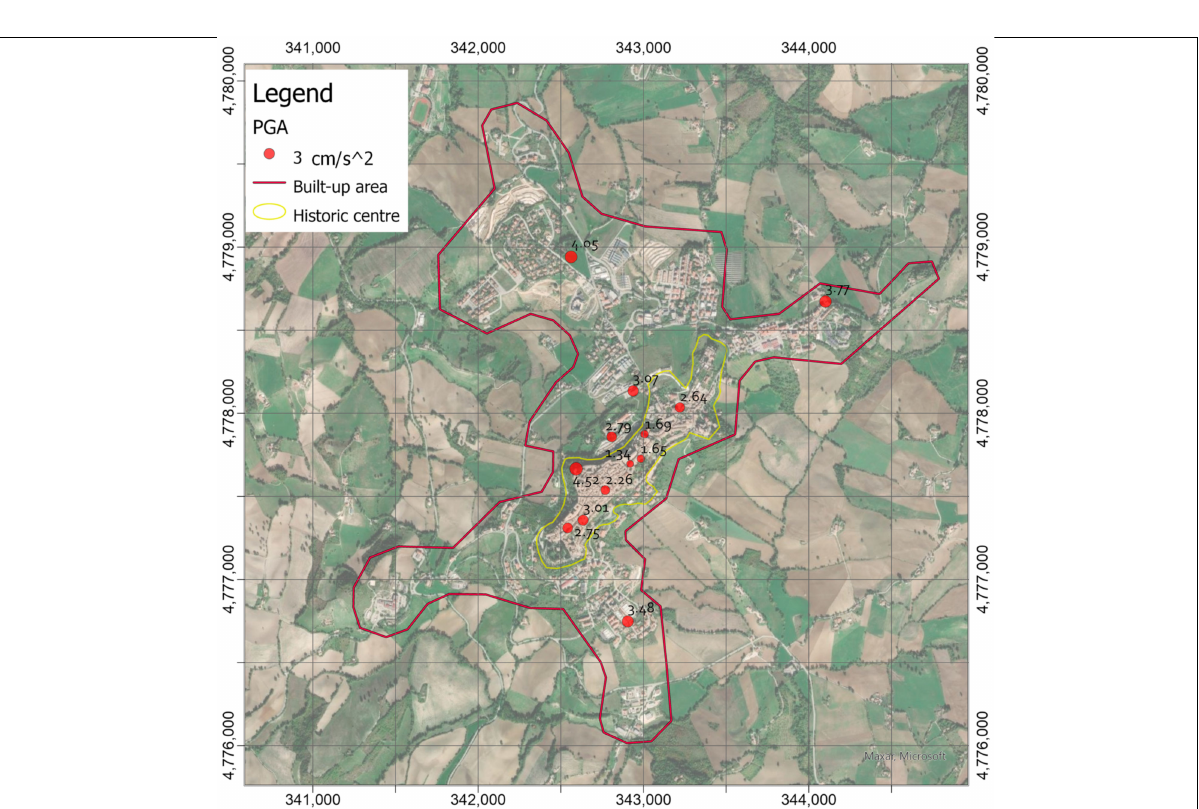
Figure 6. Peak Ground Accelerations (in cm/s 2 ) recorded by the accelerometric network during the ML 3.3 earthquake with epicenter at Fiordimonte (MC) 13 km South of Camerino on 18 April 2021 (http://cnt.rm.ingv.it/en/event/26473301, accessed on 3 November 2021).